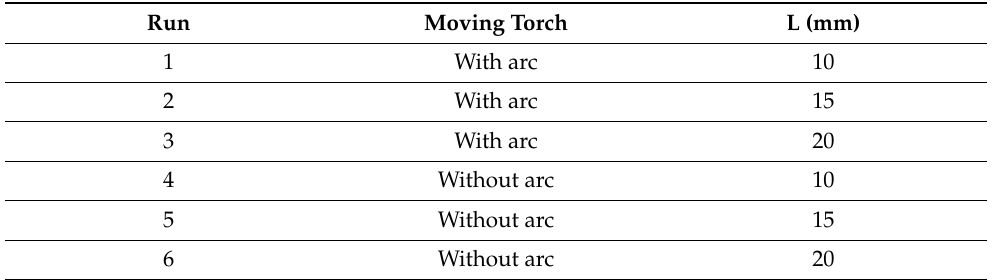
Table 1. Experimental design to assess the influence of the “L” distance on the pyrometric thermal profiles. Run Moving Torch L (mm) 1 With arc 10 2 With arc 15 3 With arc 20 4 Without arc 10 5 Without arc 15 6 Without arc